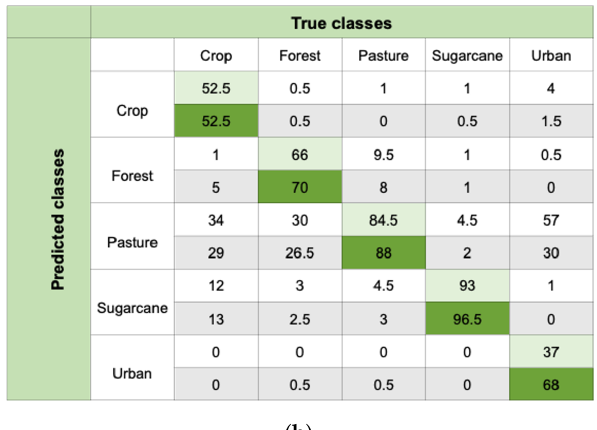
Figure 8. Confusion matrix of ( a ) field-pixel and ( b ) field sampling; with SVM classifier: each cell included two values, where upper ones are only based on using intensity while the lower values are related to using intensity and coherence